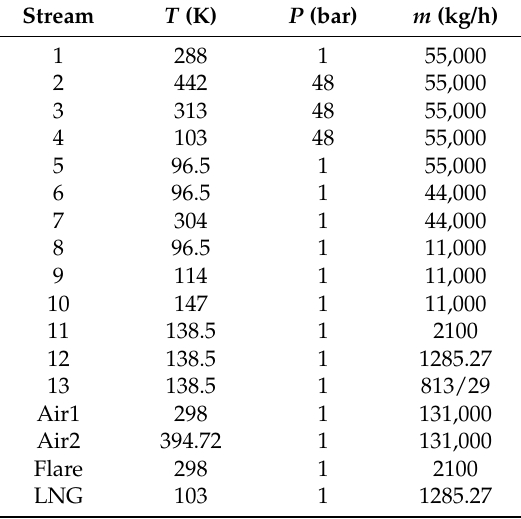
Table 2. Specifications of cycle in Figure 3.